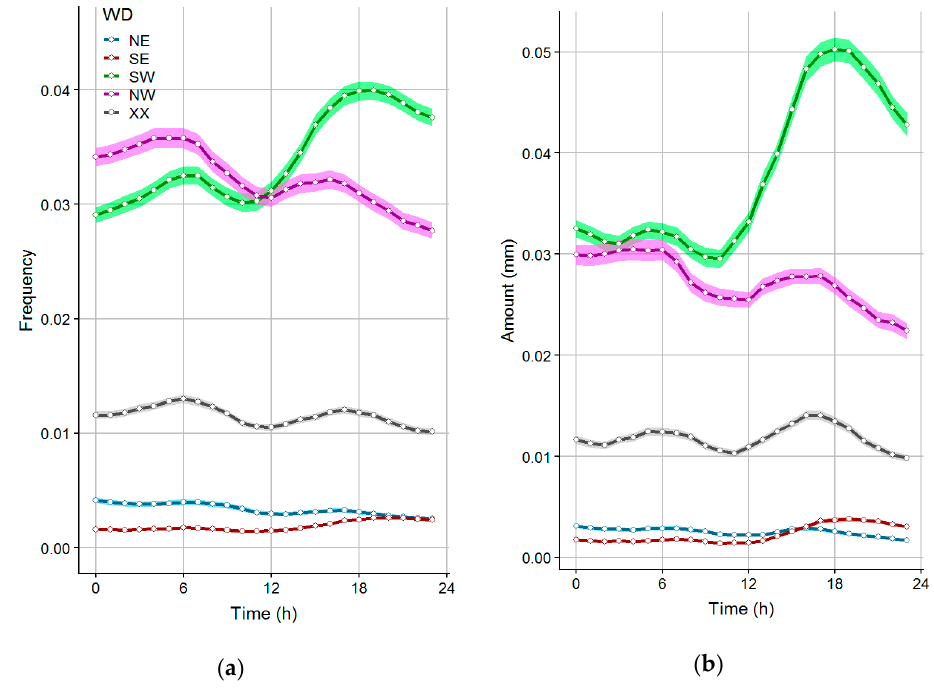
Figure 8. Precipitation diurnal cycle in different wind direction (WD) classes represented by the long-term averages of the hourly precipitation occurrence frequency ( a ) and the hourly precipitation amount ( b ) with the shaded 95% confidence intervals.